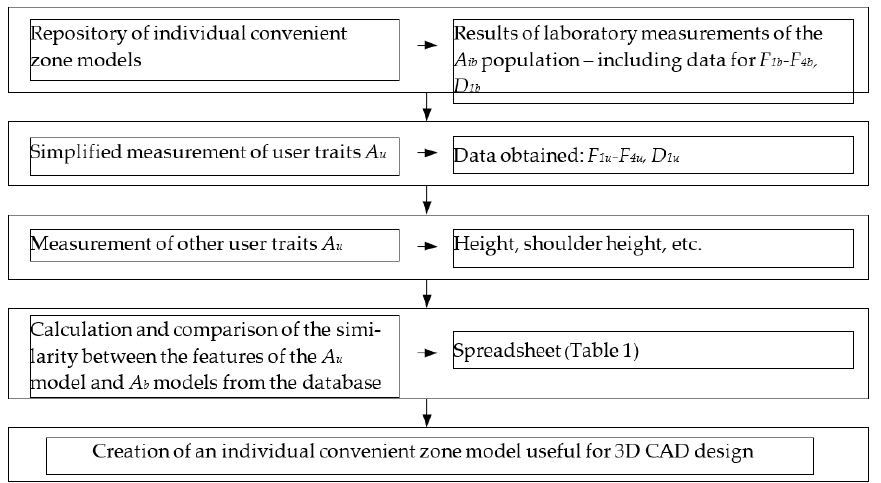
Figure 4. Algorithm for fitting the simplified A u model to a model from the A b database.